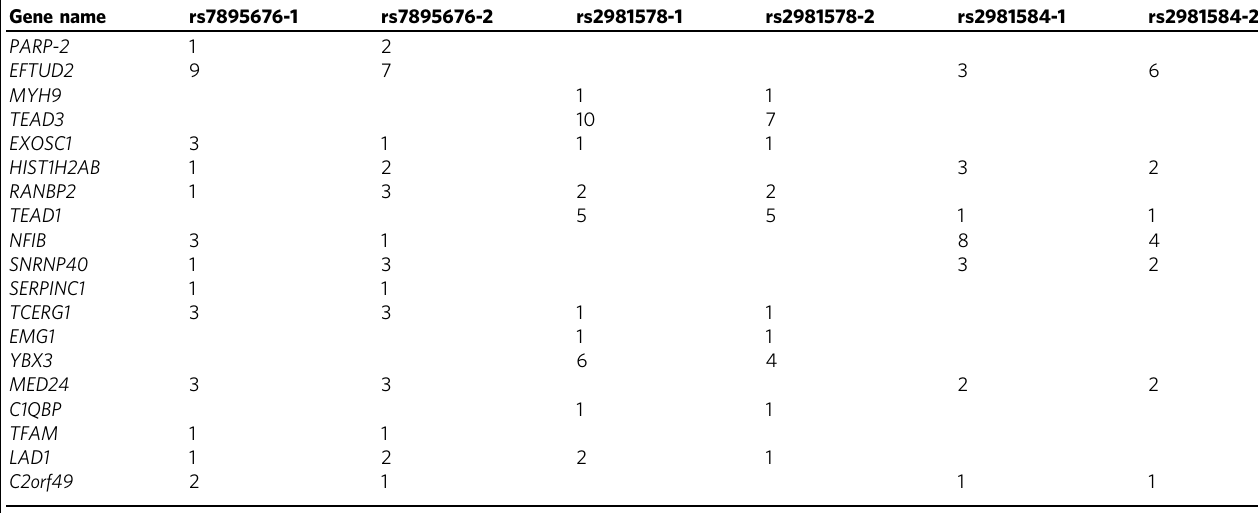
Each SNP was performed in